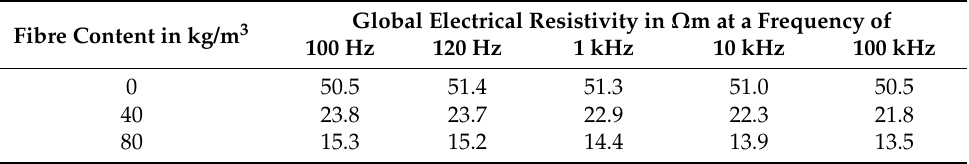
Table A37. Results of the resistivity measurements of the concrete mixture 32-60-300-00 after storage in H 2 O for 28 days for the investigations of possible leaching